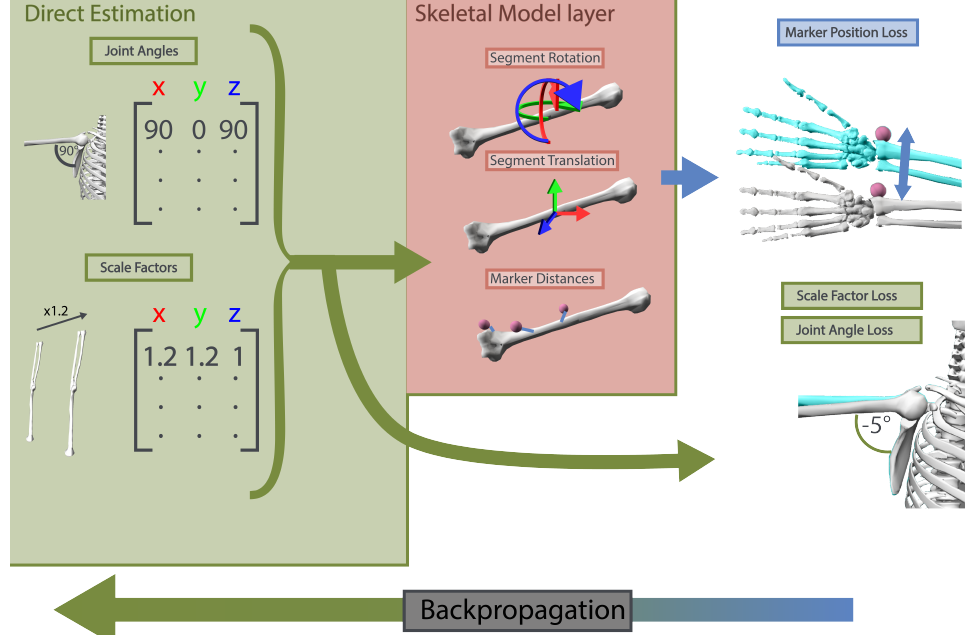
Figure 3. Our skeletal-model layer uses an internal representation of a skeletal model to convert the predicted joint angles and scale factors to the positions of individual markers on segments of the skeletal model. This allows our method to be supervised during training not only on errors(losses) in the estimation of joint angles but also on errors in the resulting pose. On the right, we show the additional error that is created between estimations (gray) and ground truth (blue). This auxiliary estimation of the pose as 3D marker positions helps to constrain the estimation of joint angles as small changes in proximal joints can have a large effect on a marker at more distal